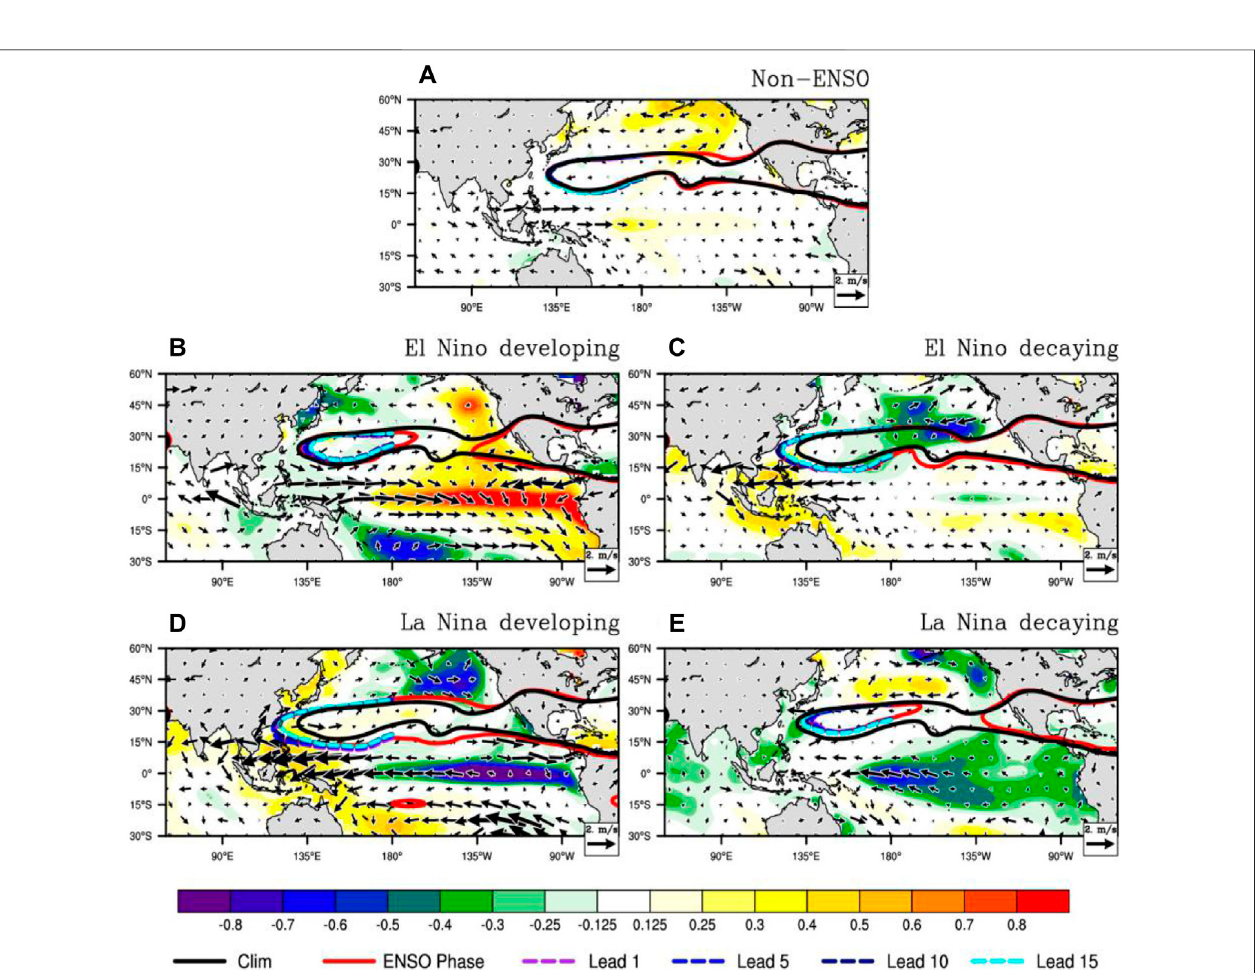
FIGURE5| Composites for5880-gpmover 500-hPa height fi eld[contours, blacklinerepresentallyearsduring 1985 – 2019and colorlines arefor aspeci fi cphase ofENSOinobservation(red)andthemodelatdifferentleaddays],SST(shading,units: ° C)and850-hPawindanomalies(vector,m s − 1 )duringthenon-ENSO (A) ,ElNiño developing (B) , El Niño decaying (C) , La Niña developing (D) and La Niña decaying (E) summers.